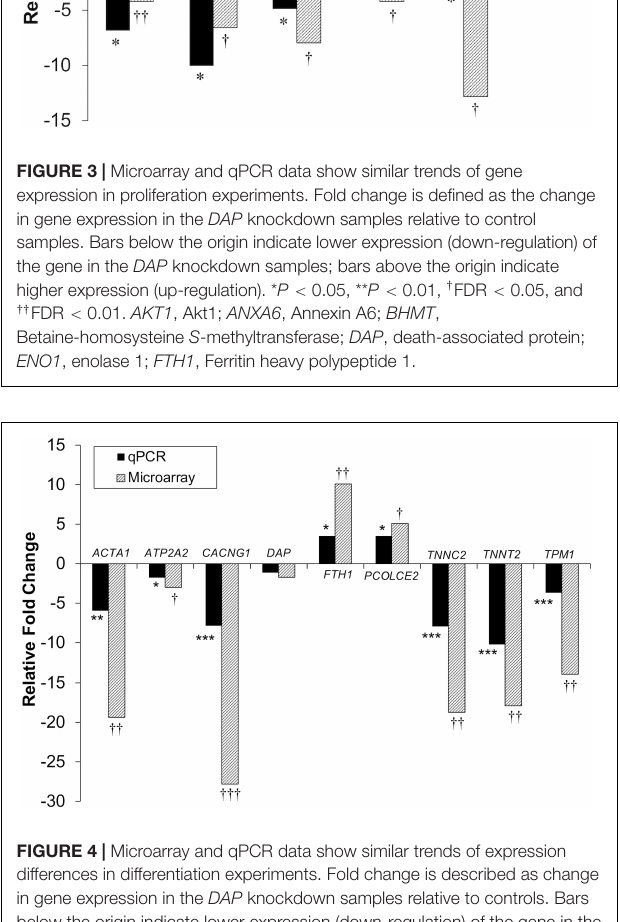
FC = − 2.20 vs 2.53), and procollagen C-endopeptidase enhancer 2 ( PCOLCE2 , FC = − 6.4 vs 5.1).